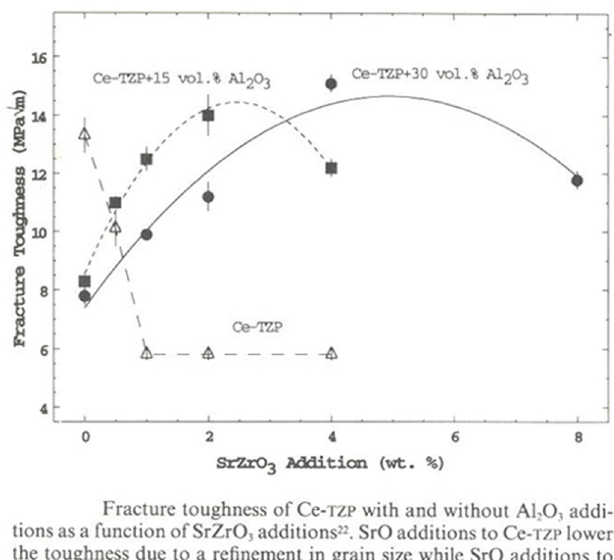
Figure 36. Fracture toughness related to the addition of SrO and final platelet formation.